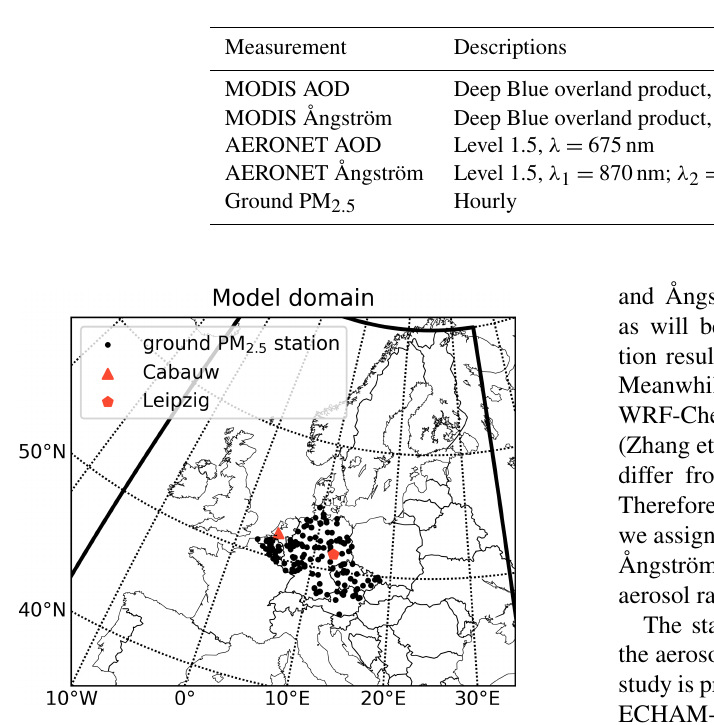
Figure 5. Model domain and locations of ground PM 2 . 5 stations and AERONET sites at Cabuaw and